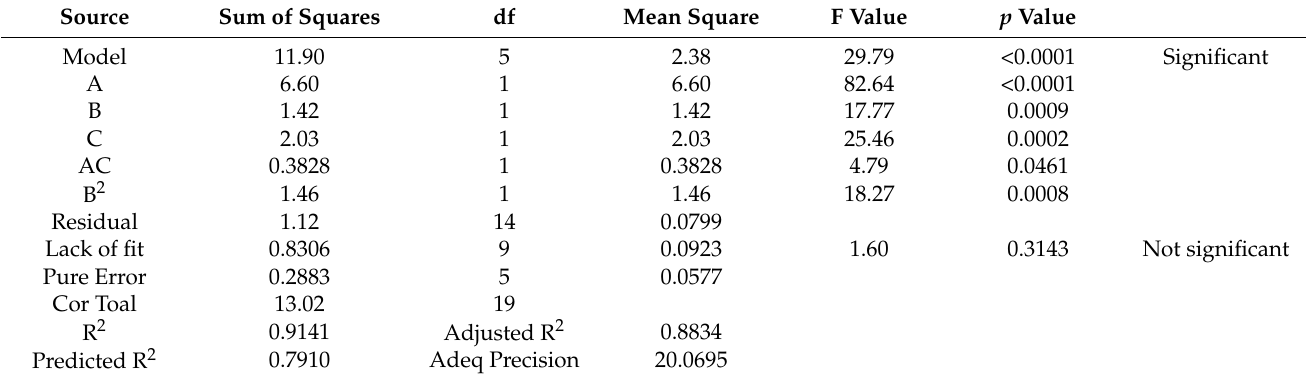
Table 5. ANOVA table for dilution